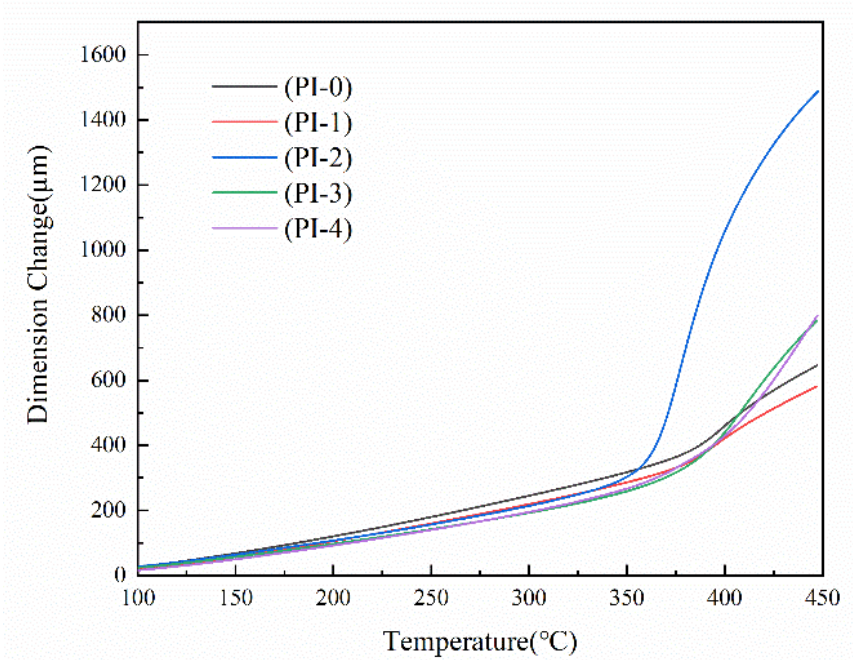
Figure 6. TMA curves of the PI films.